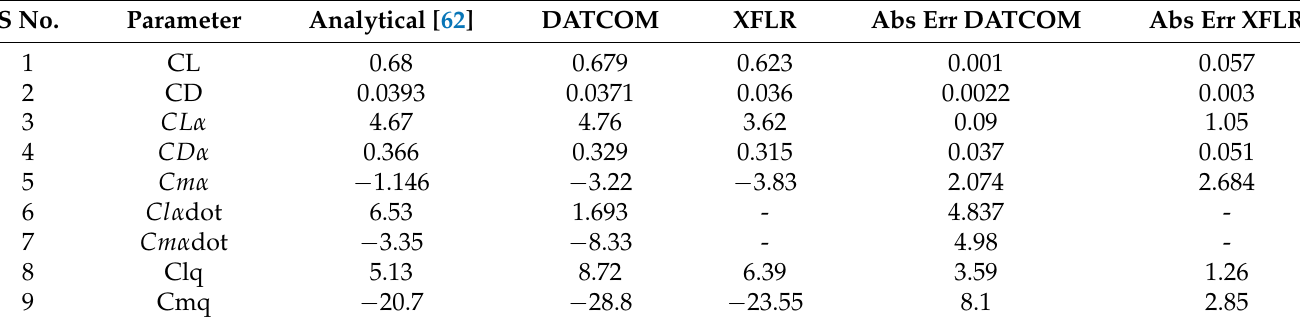
Table A1. Comparison of longitudinal stability aerodynamic coefficient results. S